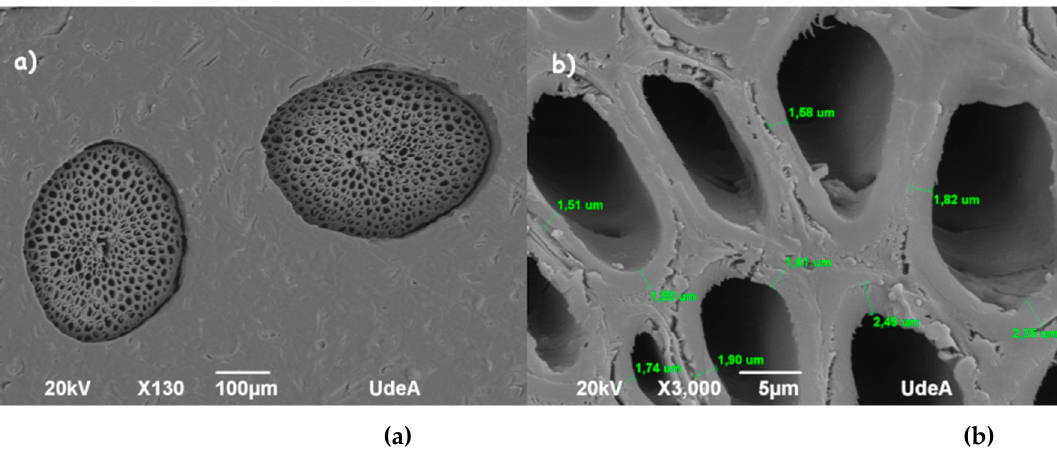
Figure 4. SEM ( a ) micrographs of coir fibers, and ( b ) lamella media and lumen of coir fibers.